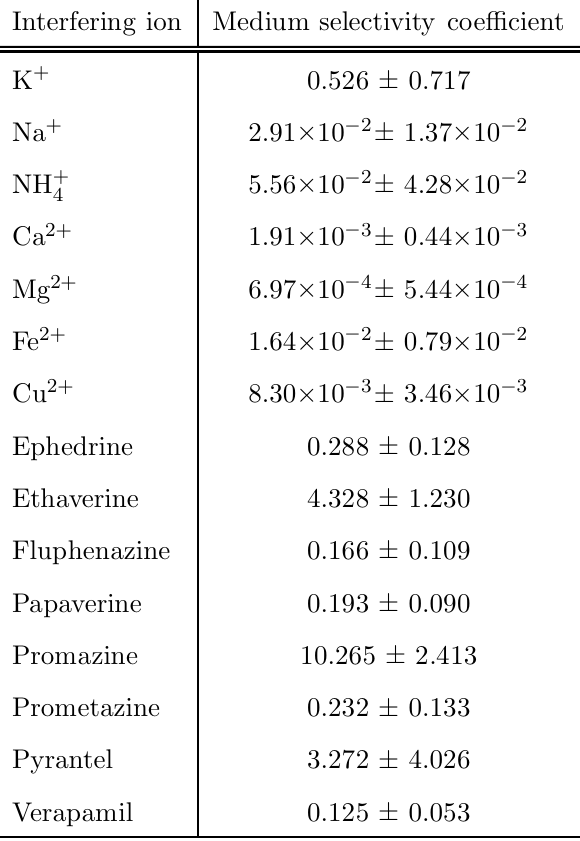
Table 2 Medium selectivity coe¯ cient values of selected cations (labetalol hydrochloride con- centration: 1 £ 10 ¡ 4 mol L ¡ 1